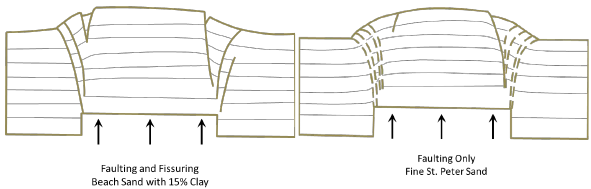
Figure 7. Results of sandbox experiments demonstrating fissuring and faulting consistent with shear and tensile failure of an elastic body exhibiting differential offset at depth (modified from Sanford, 1959 by Carpenter,